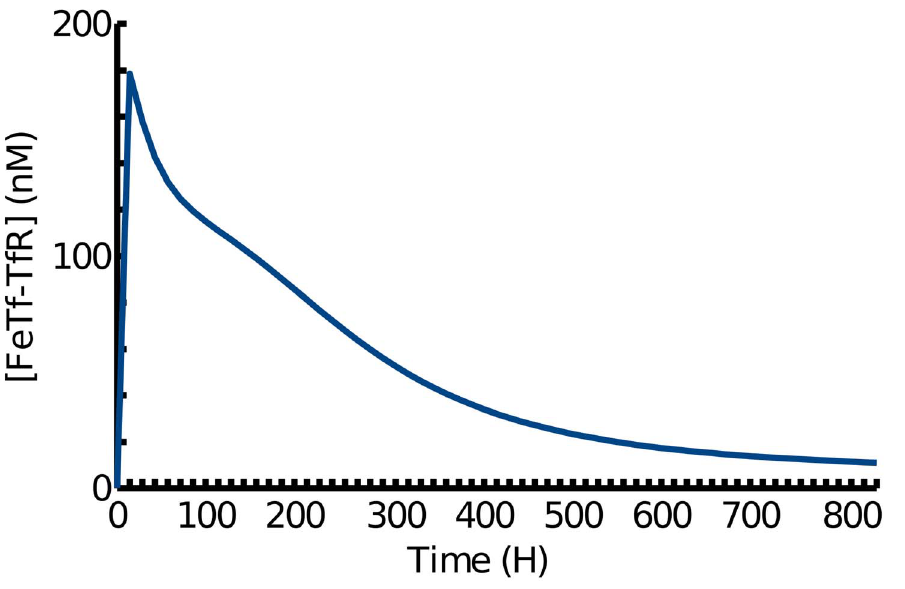
Figure 6. Iron and Epo receptors show a similar response following an impulse of ligand. Ligand receptor binding for iron shows a distinctive curve which closely resembles EPO receptor binding studied by Becker et al. 2010 [34] (their Fig. 2B).